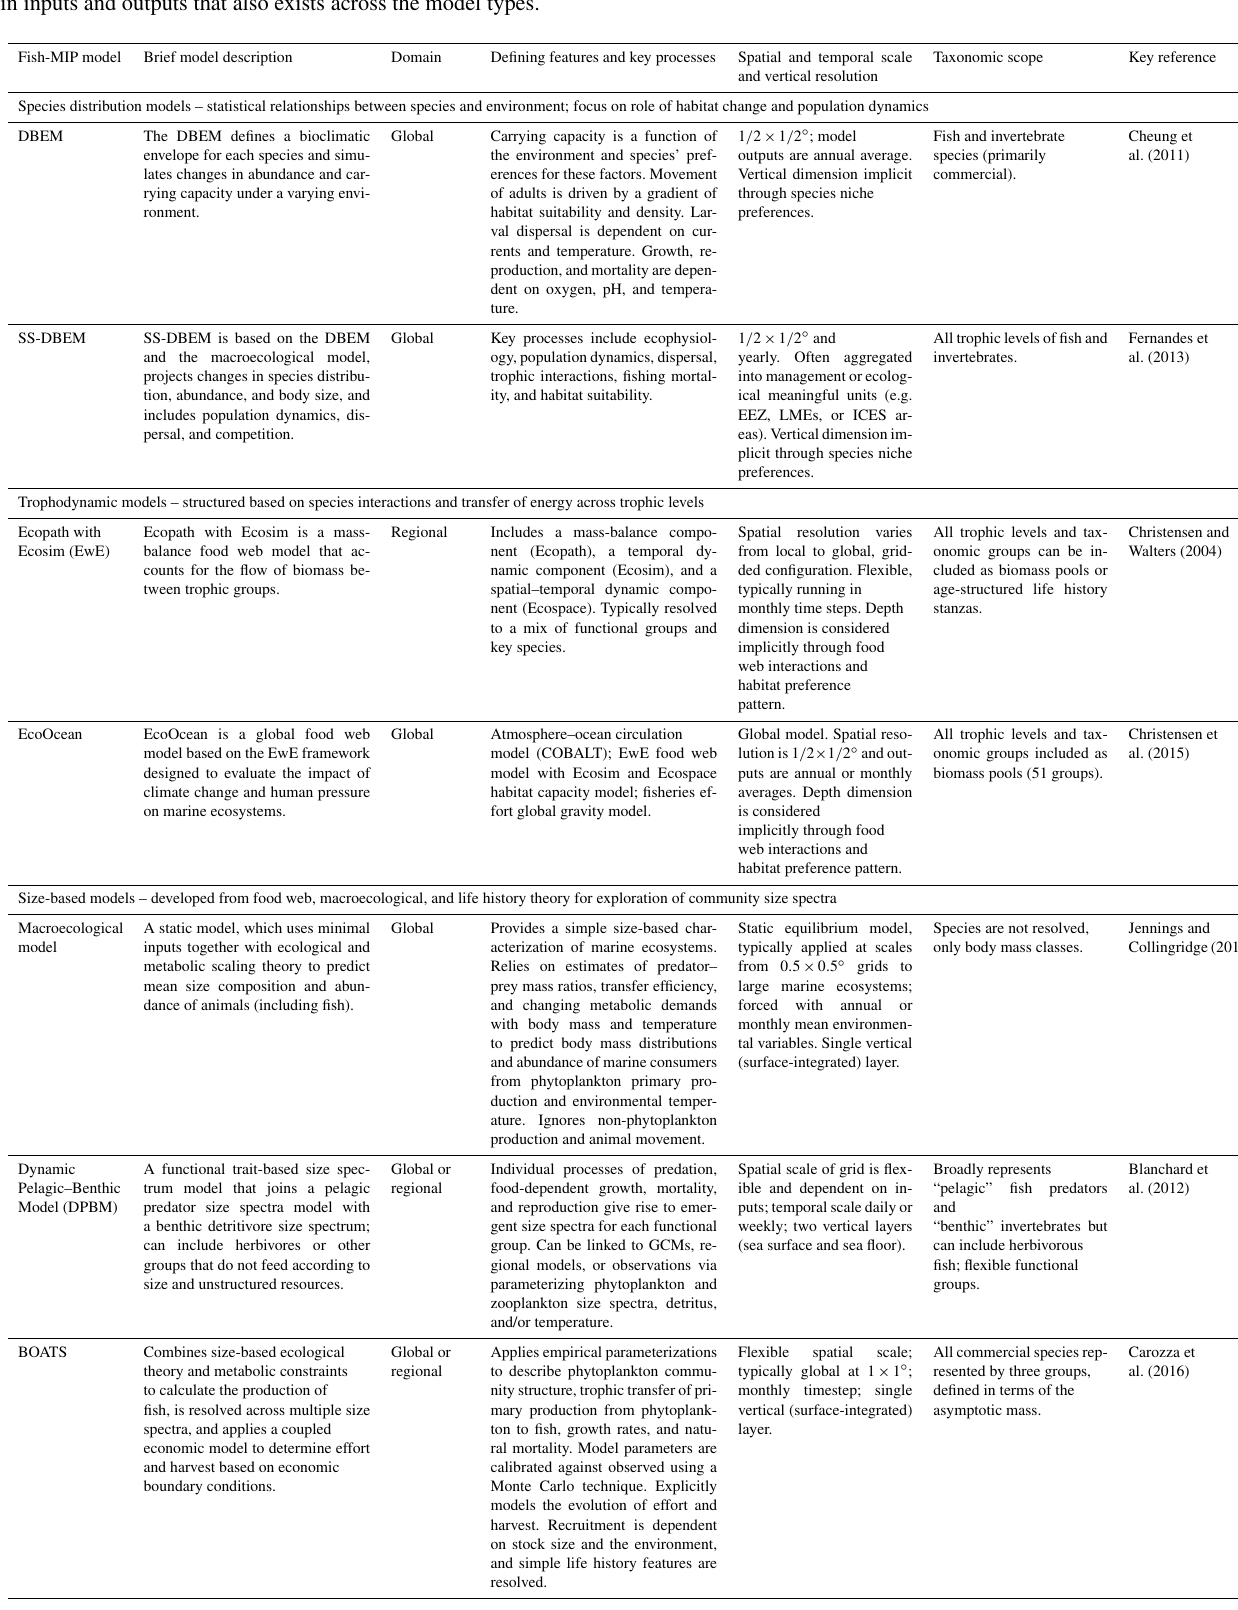
Table 1. A taxonomy of marine ecosystem models taking part in the Fish-MIP project. See also Tables 2 and 3 for the degree of heterogeneity in inputs and outputs that also exists across the model